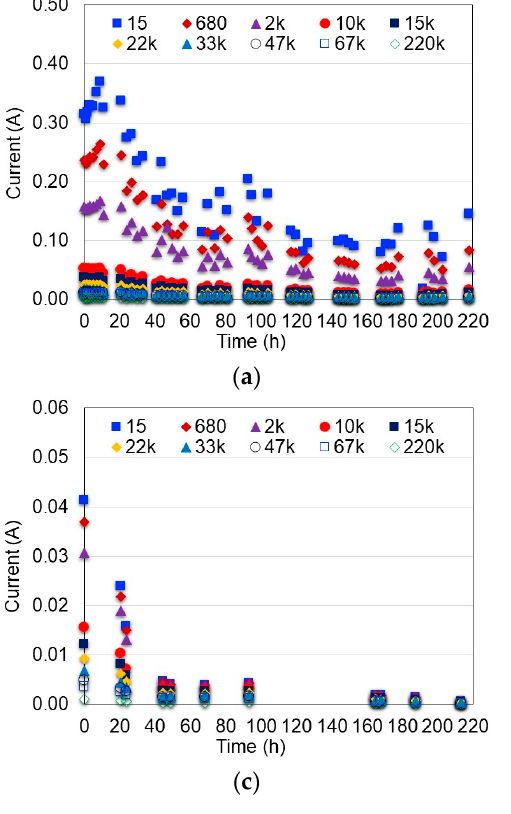
Figure 5. E ff ect of the external resistance ( Ω ) on the MFC current. ( a ) Water and hydrophilically- Figure 5. Effect of the external resistance ( Ω ) on the MFC current. ( a ) Water and hydrophilically- treated graphene (DW-HTG); ( b ) HCl and hydrophilically-treated graphene (HCl-HTG); ( c ) Water treated graphene (DW-HTG); ( b ) HCl and hydrophilically-treated graphene (HCl-HTG); ( c ) Water and graphite (DW-G); ( d ) HCl and graphite (HCl-G). and graphite (DW-G); ( d ) HCl and graphite